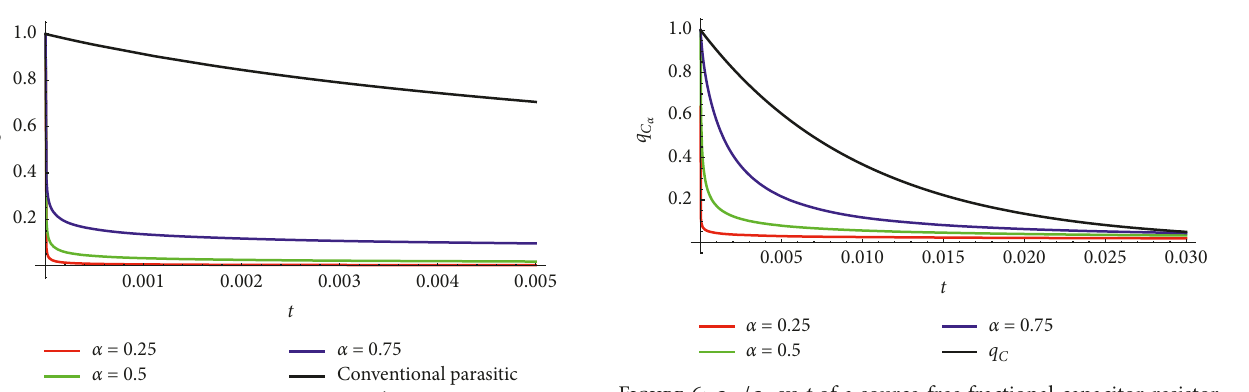
Figure 6: q q C α / C vs t of a source-free fractional capacitor-resistor circuit/a source-free conventional capacitor-resistor circuit.